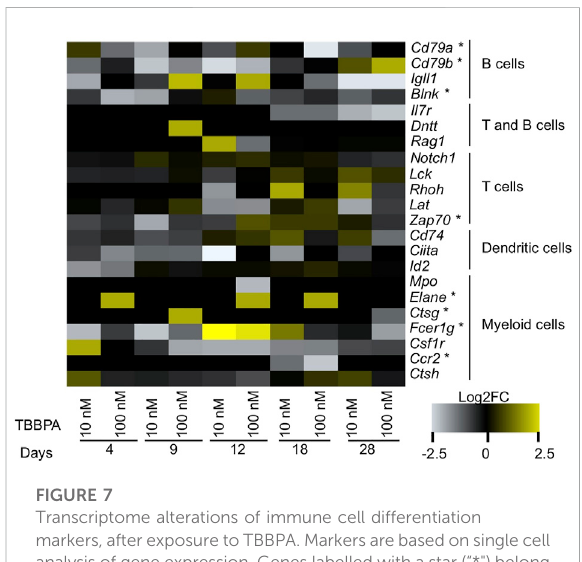
FIGURE 7 Transcriptome alterations of immune cell differentiation markers, after exposure to TBBPA. Markers arebased on single cell analysis of gene expression. Genes labelled with a star ( “ *") belong to the